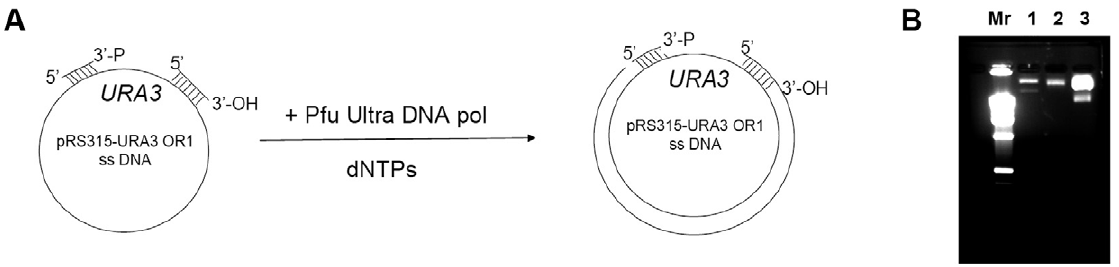
Figure 4. Construction of circular gapped DNA substrate for the invitro deaminase assay. a. Scheme of substrate construction (See Materials and Methods for details). b. Agarose gel analysis of the reaction products. The gel was stained with ethidium bromide (EtBr). Mr – molecular weight marker, 1 – original ssDNA, 2 – ssDNA with two oligonucleotides annealed, and 3 – gapped substrate – product of Pfu Ultra reaction. Lanes 1 through 3 contain similar amounts of DNA by molarity. The gapped substrate band on lane 3 is much brighter than the ssDNA on lanes 1 and 2 because double-stranded DNA binds much more EtBr than the ssDNA of the same length due to intercalation of EtBr in the double helix. The lower bands on lanes 1 and 3 represent linear DNA species that arise due to damage to the circular ssDNA.